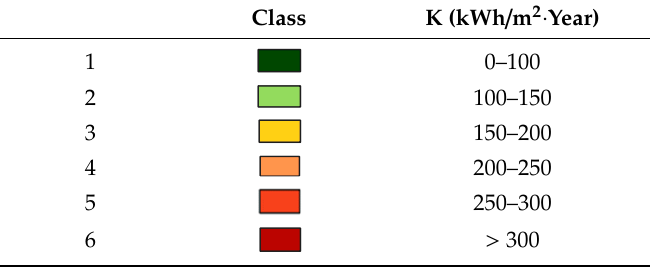
Table 1. Consumption classes according to the energy map visualization. Table 2. Summary of resulting data.